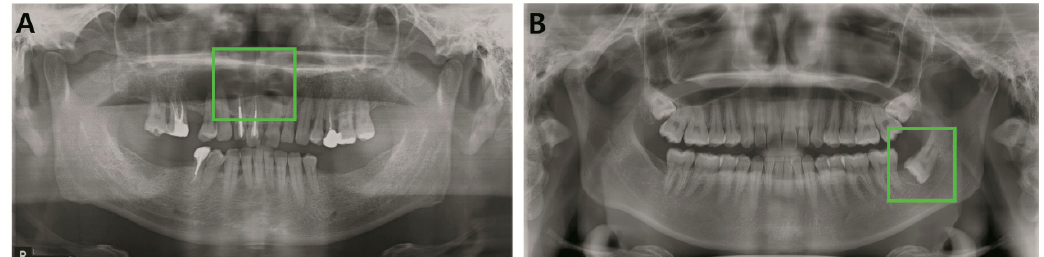
Figure 9. ( A ). Maxilla OKC was correctly detected and classified by YOLO while one-third of clinicians failed detection. ( B ). Mandible dentigerous cyst was correctly diagnosed by YOLO while two-thirds of clinicians failed detection.